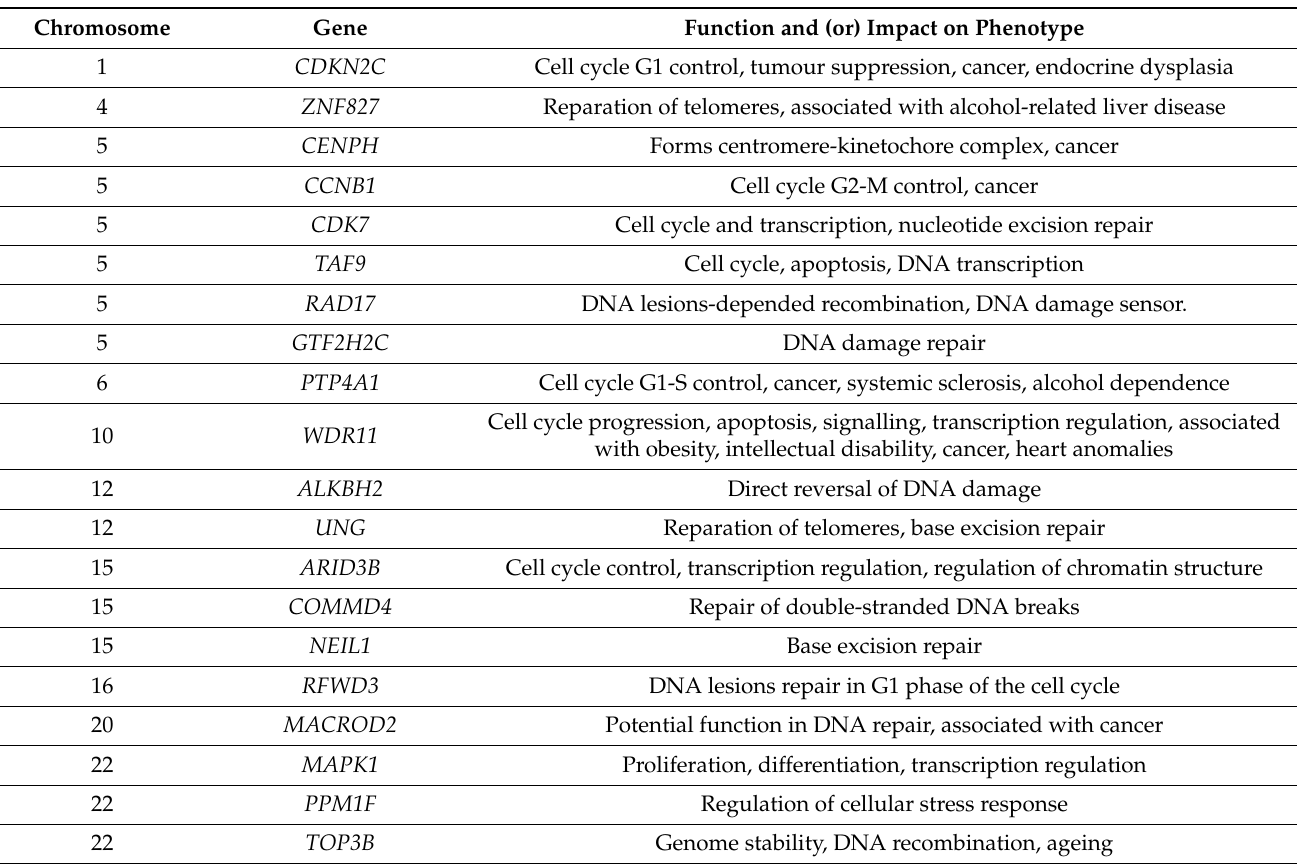
Table 2. List of the identified genes under positive natural selection involved in the DNA damage repair and cell cycle, which may contribute to the survival and well-being of LCWC. Function or impact on the phenotype was determined from data provided in the UCSC genome browser, OMIM, Human DNA Repair Genes databases, and analysis of scientific